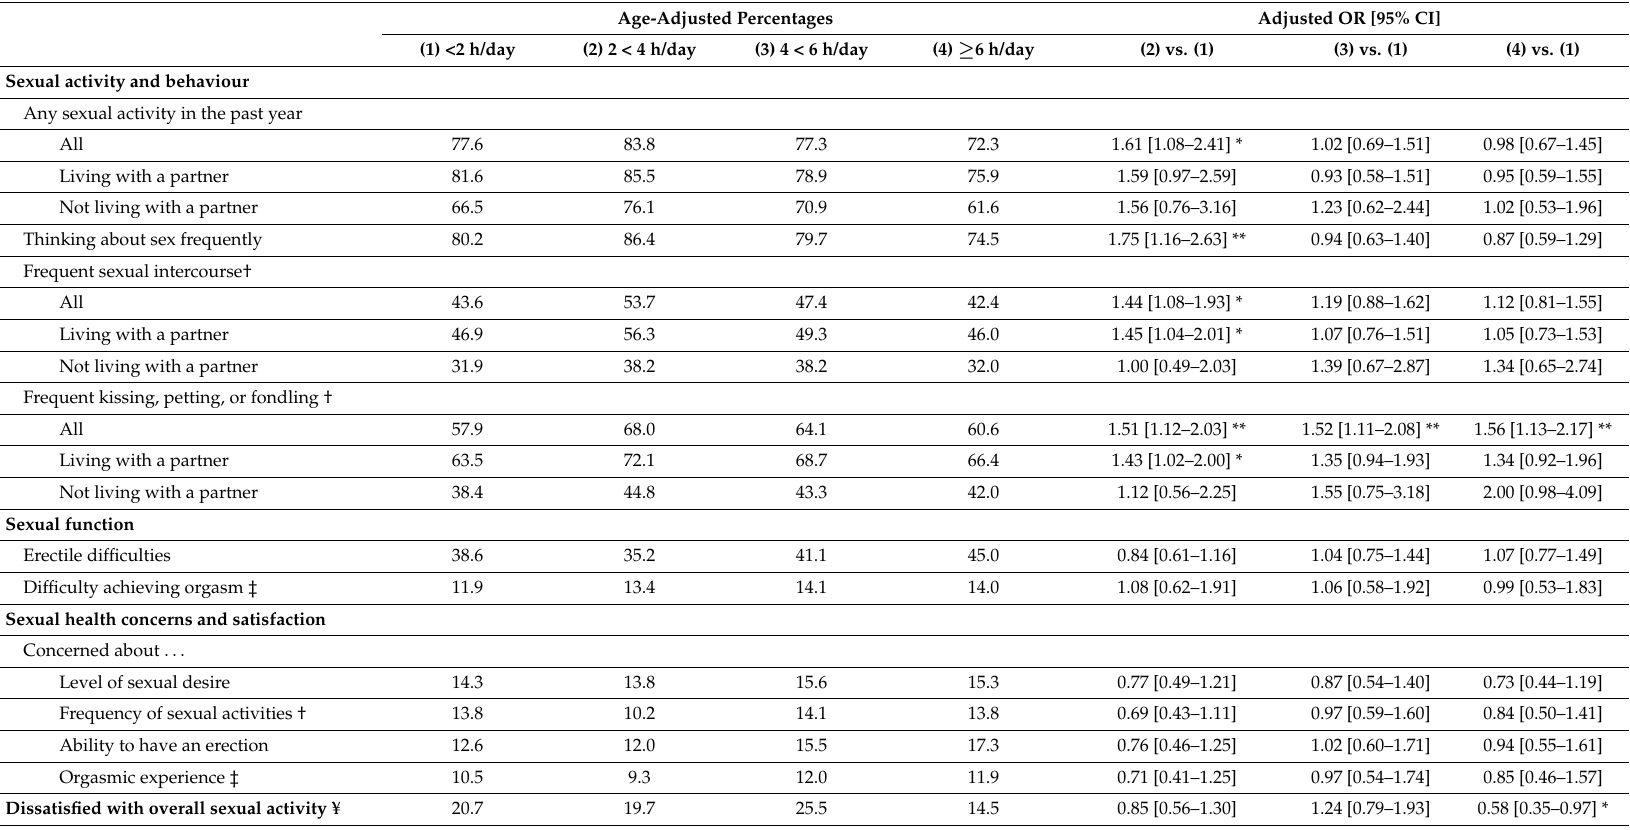
Table 4. Sexual activities, functioning and concerns in relation to hours of daily TV